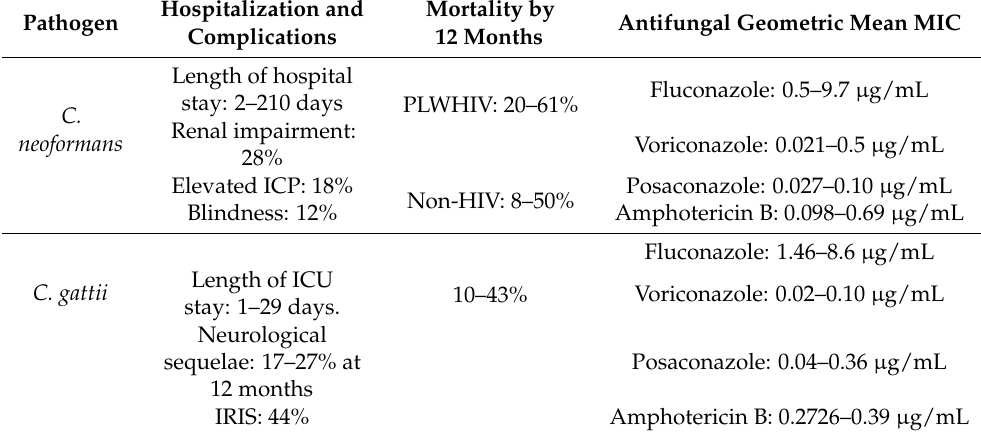
Table 2. Comparison of morbidity, mortality, and antifungal susceptibilities between C. gattii and C. neoformans